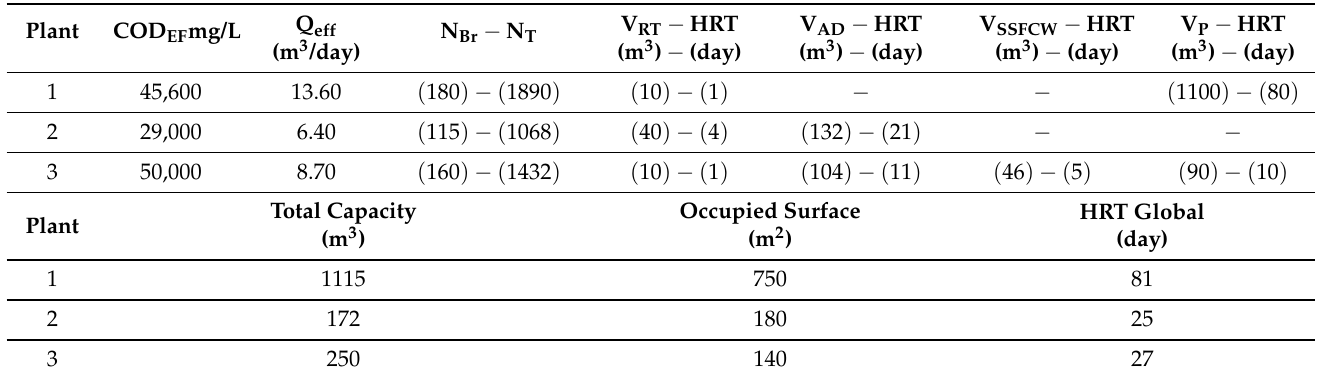
Table 1. Data pilot